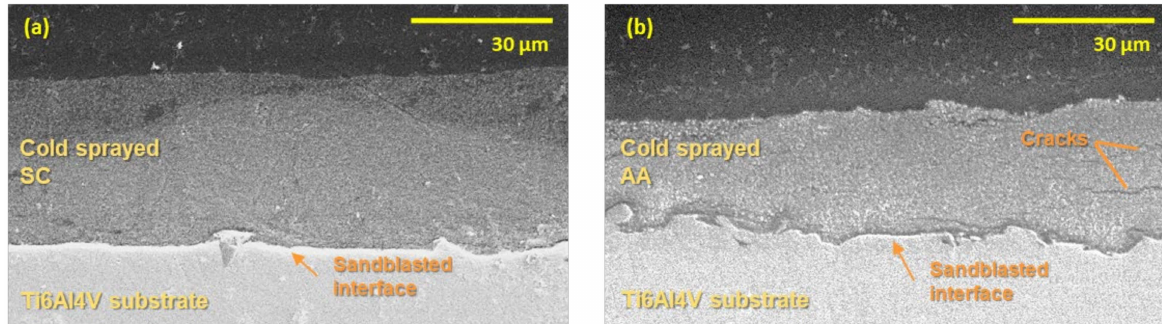
Figure 7. BNAc coating on plasma sprayed HA underlay at SEM.